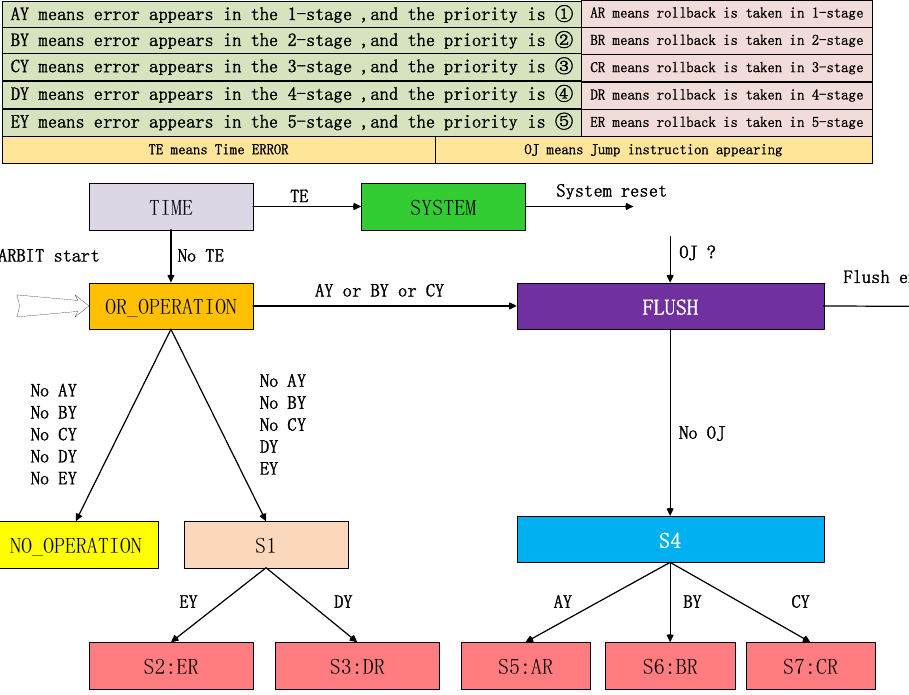
Figure 16. Internal operation diagram of the ARBIT module.